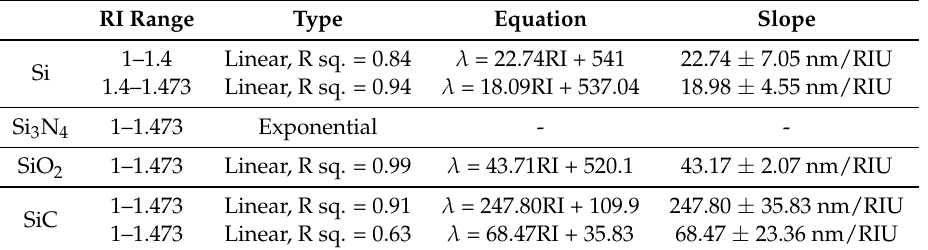
Table 3. Curve fitting parameters of the sensitivities of AuNI for refractive index